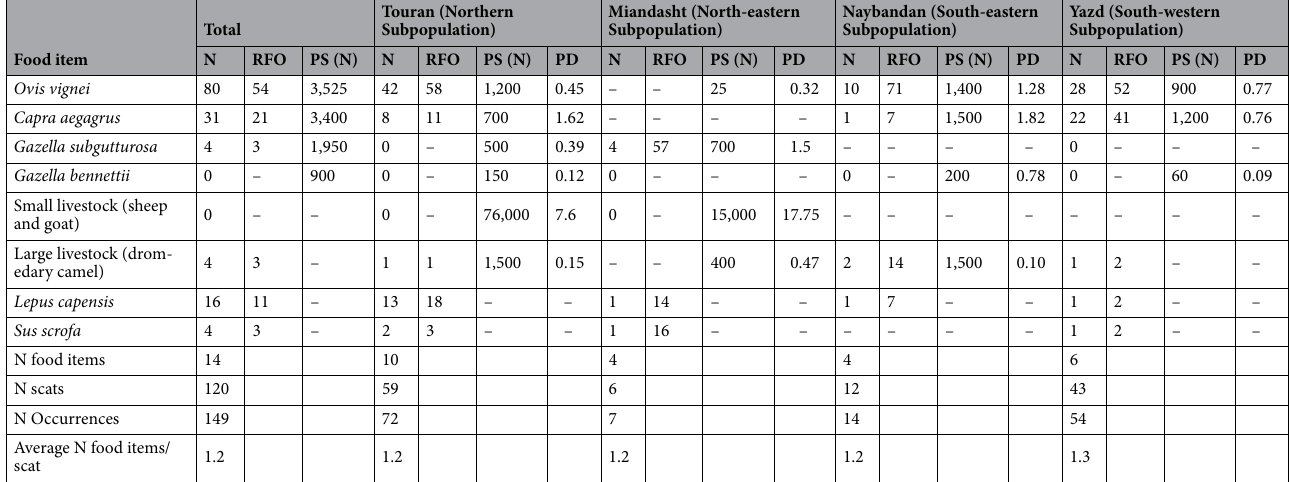
Table 3. Number of scats containing each food item (N), relative frequency of occurrence (RFO), prey population size (PS) and prey density (PD) (prey population/km 2 ) for each prey item, in total and in each study area. *”N food items” is total number of food items found in each study area; “N scats” is the total number of scats from each area with identified prey items; “N occurrences” is the total number of occurrences of each prey items in all scats from each study area; “Average N food items/scat” is the number of food items in each area divided per number of scats in that area. Prey population size was extracted from DoE unpublished reports and enquiries from managers of protected areas in 2017. Prey density was calculated by dividing prey population by the distribution range of target prey species based on Yusefi et al. 67